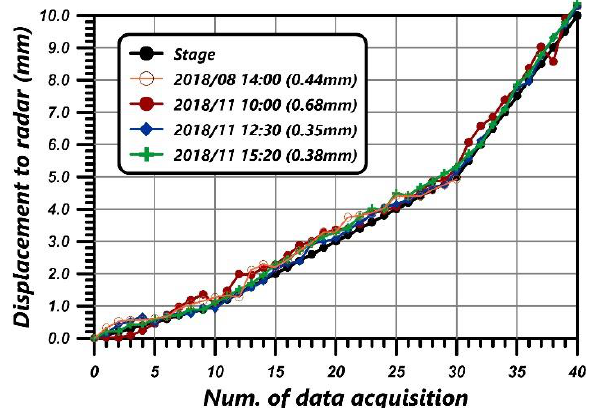
Figure 6. The verification test result of displacement measurement accuracy